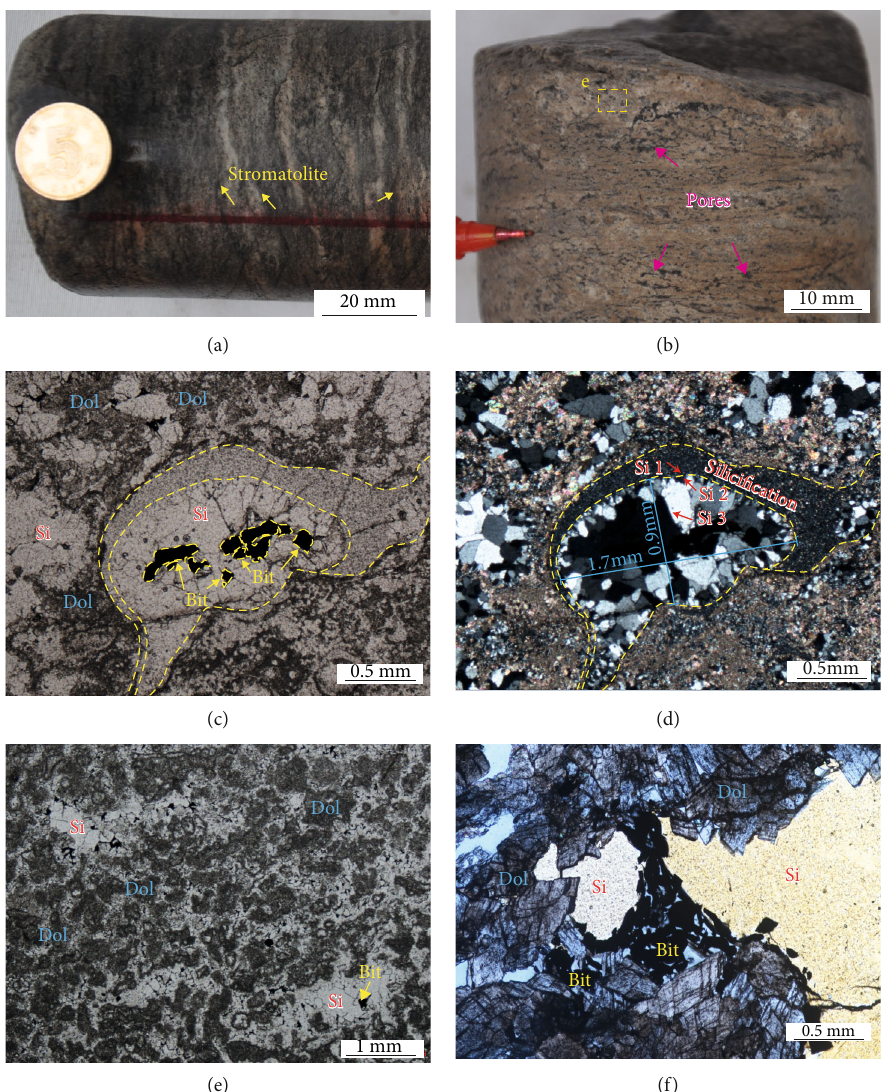
Figure 3: Lithology and pore characteristics of MS well #1 Z dn 4 member reservoir. (a) Stratiform algal dolomite, MS well #1, 8,053.87 – 2 8,054.64 m; (b) needle-like micropores, MS well #1, 8,053.47 – 8,053.87 m; (c) solution pores with a pore size of approximately 0 : 9 × 1 : 7 mm fi lled with minerals, MS well #1, 8,053.99 m; (d) orthogonal polarised photo of c; (e) algae-condensed dolomite, where the original lattice hole was strongly silici fi ed, MS well #1, 8,054.46 m; (f) intergranular solution pores of recrystallised dolomite, semi- fi lled with bitumen particles and authigenic quartz, MS well #1, 8,056.19